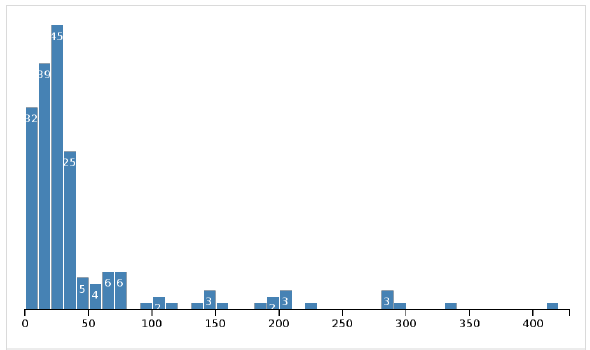
Figure 17: Histogram of nanomaterial sizes created with d3.js and ambit.js.